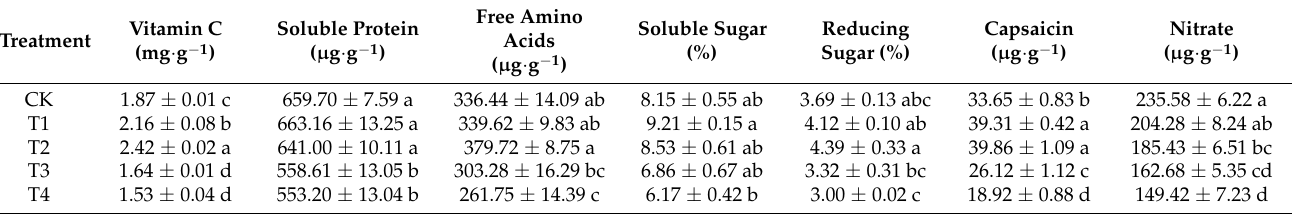
Table 2. Effects of reduced fertiliser application before harvesting on the nutritional quality of